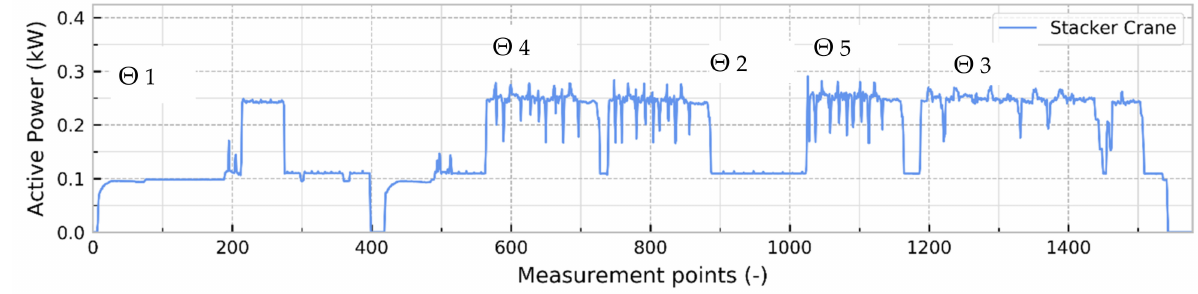
Figure 3. Time series of power for the RBG. Θ 1 is the ‘ standby ’ mode, Θ 2 resembles the ‘ wait for approval ’ state. In Θ 3–5, the stacker crane carried 20%, 50% and 100% of its maximum load.